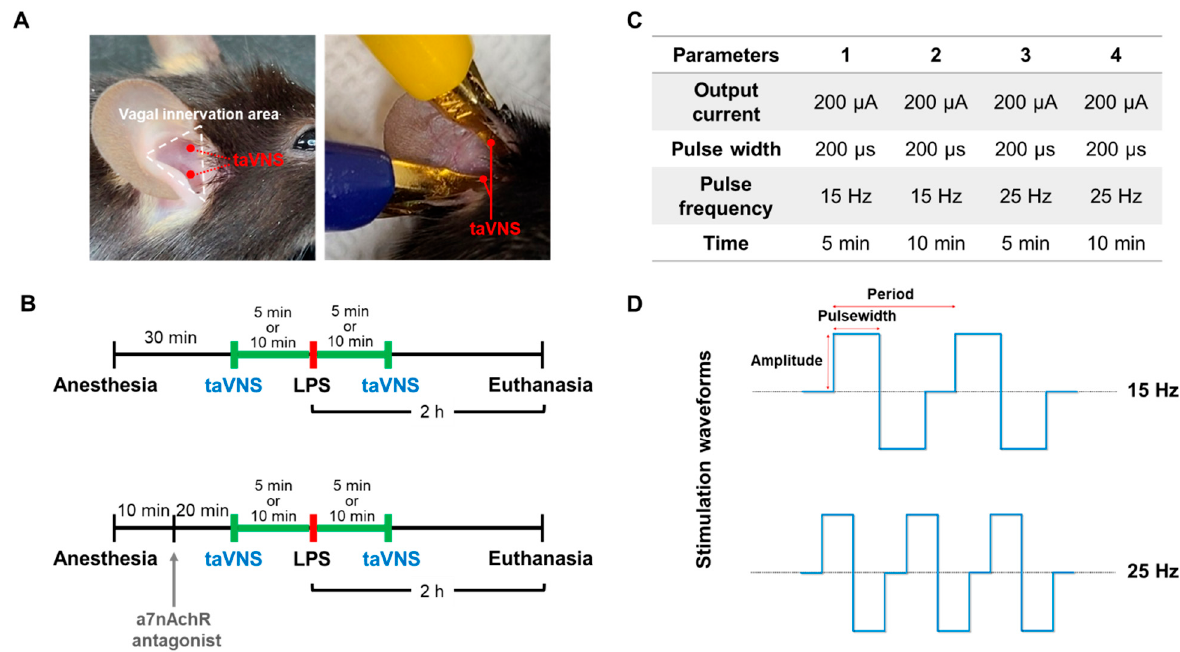
Figure 1. Experimental design and procedure of taVNS in the LPS-induced endotoxemia in mice. ( A ) Mice were bilaterally treated with taVNS, followed by the cymba and cavum concha of the vagus innervation area in the ear. ( B ) Under anesthesia, mice were stimulated with taVNS treatments for 5 or 10 min before and after LPS injection. The animals were euthanized after 2 h of LPS administration, and the whole blood and tissues were collected. ( C ) Four different taVNS parameters were used during stimulation in this study. ( D ) Schematic image showing the charge-balanced stimulation waveform of taVNS with low pulse frequency ( top ) and high pulse frequency ( bottom ).